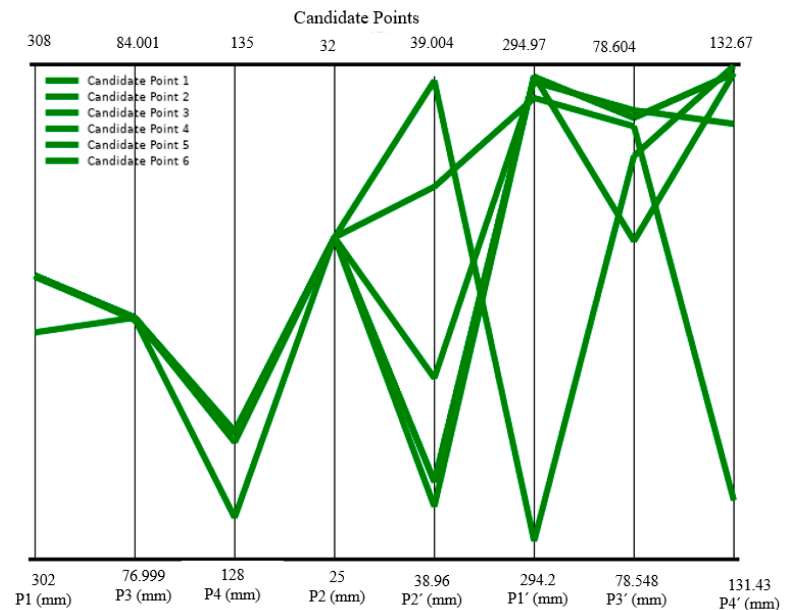
Figure 14. Range of parameters and place of candidate points.